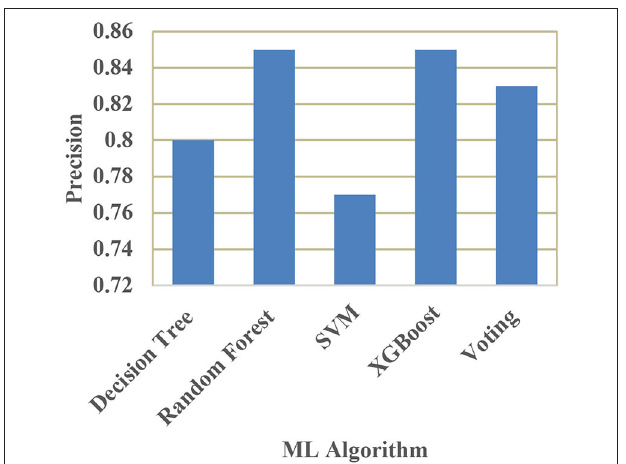
FIGURE 15 | Comparison of precision.